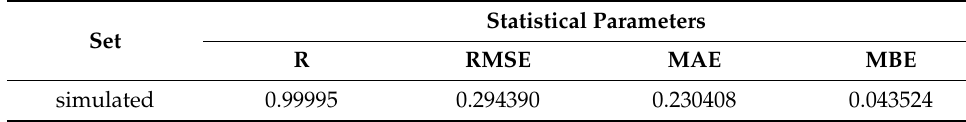
Figure 7. Error histogram of simulated data for ANN model. After finalizing the ANN model, it is important to establish a link or relationship between the input and the output. In general, a sensitivity analysis is used to check the effect of a small change in an input parameter on the output variable [27–29]. Table 5 shows the correlation between the input parameters with the output param- eter using the “Correlation” function available in the “Data Analysis” toolbox in Excel. It can be shown that the weigh-left percentage is strongly “inversely” related to the temper- ature ( − 0.79722), while remaining low to the heating rate (0.04101). As mentioned above, the results presented in Table 6 show a strong correlation between temperature and weight-left percentage. With an increase in the pyrolysis temperature, the weight-left per- centage was decreased. This finding can be demonstrated by the thermogravimetric curves elsewhere [30], which have an inverted S-shape. Table 5. The correlation values between the input and output parameters. Weight-Left % (Output Parameter) Temperature (1st input parameter) − 0.79722 Heating rate (2nd input parameter)